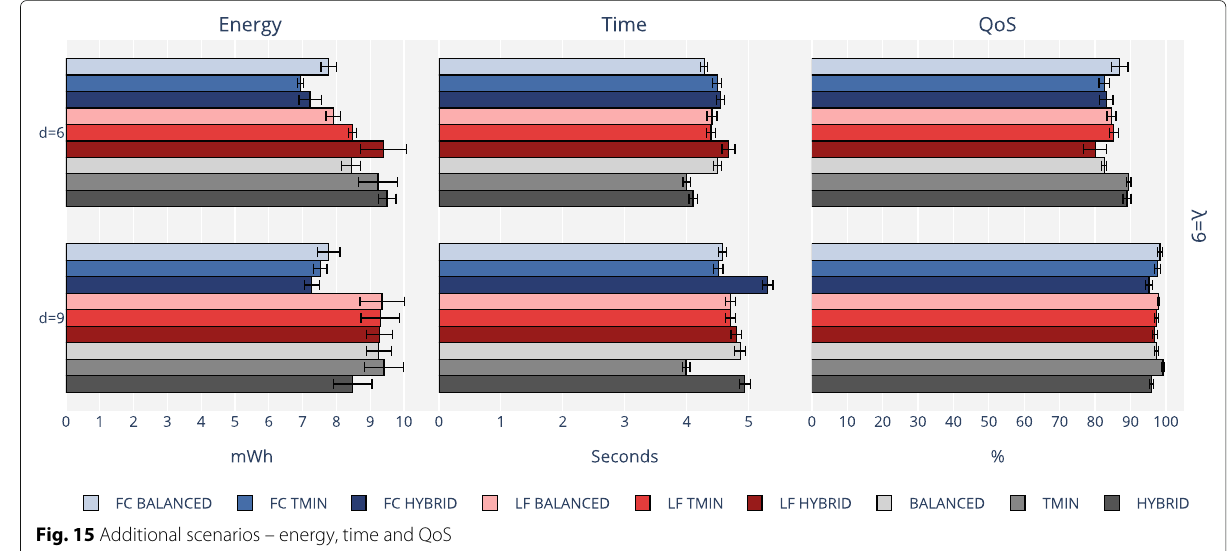
Fig. 15 Additional scenarios – energy, time and QoS